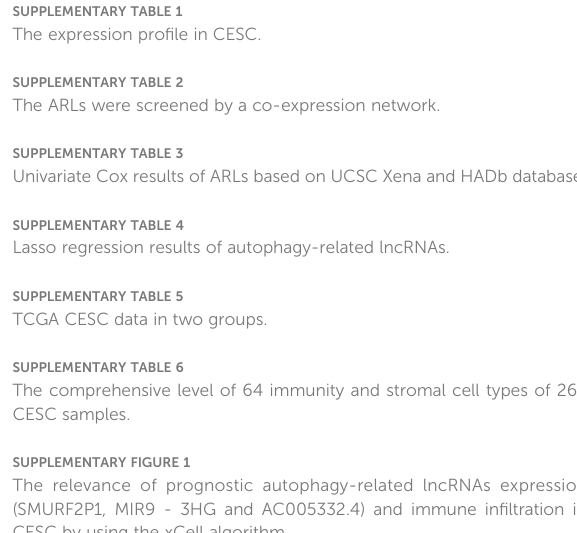
SUPPLEMENTARY TABLE 1 The expression pro fi le in CESC. SUPPLEMENTARY TABLE 2 The ARLs were screened by a co-expression network.